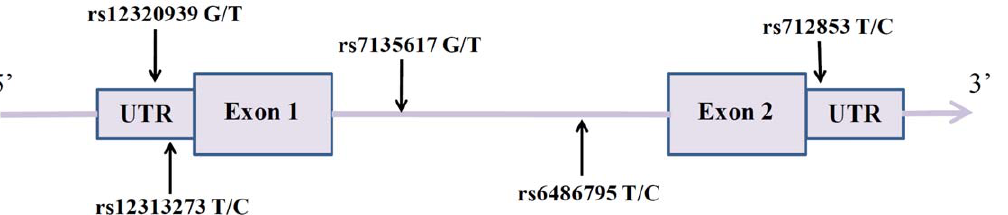
Figure 1. A graphical overview of genotyped polymorphisms identified in relation to the exon/intron structure of the human ORAI1 gene.